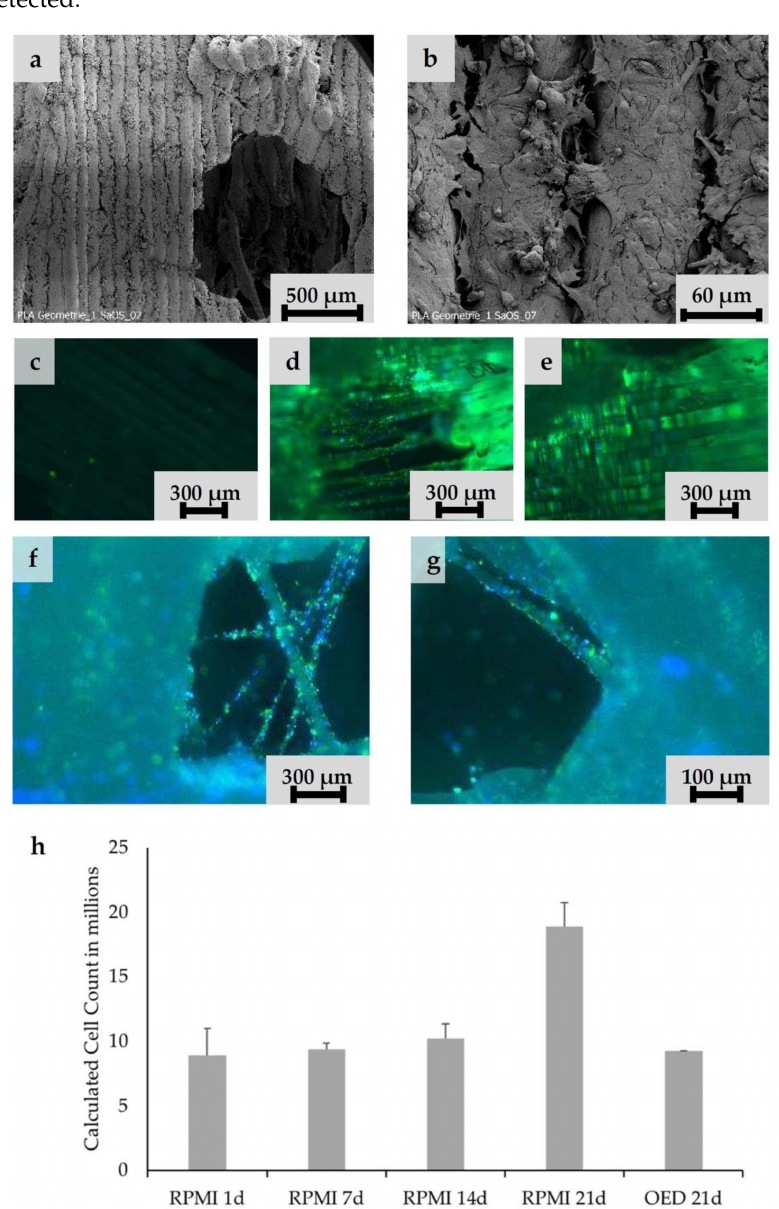
Figure 3. Cell adhesion experiments. Saos-2 cells seeded on undyed PLA sca ff olds pretreated with adhesion protein coating: ( a , b ) Ingrowth of Saos-2 cells into the layers intercolumn and macroscopic pores is visible. ( c , d ) CFSE staining of native and CellTak pretreated PLA surfaces. ( c ) Native surface without preconditioning. Only a few cells were adherent. ( d , e ) CellTak -preconditioned surfaces showed increased cell adhesion. ( f , g ) CFSE / DAPI staining of Saos-2 cell coated sca ff old (Design 2); cells appear green (CFSE) with blue nucleus (DAPI). ( f ) Stringing in a pore covered with vital cells. ( g ) Onsight on a pore with stringing structure. On all structural features, multiple vital cells are visible. ( h ) Calculated cell counts based on MTT-Test results after 1, 7, 14, and 21